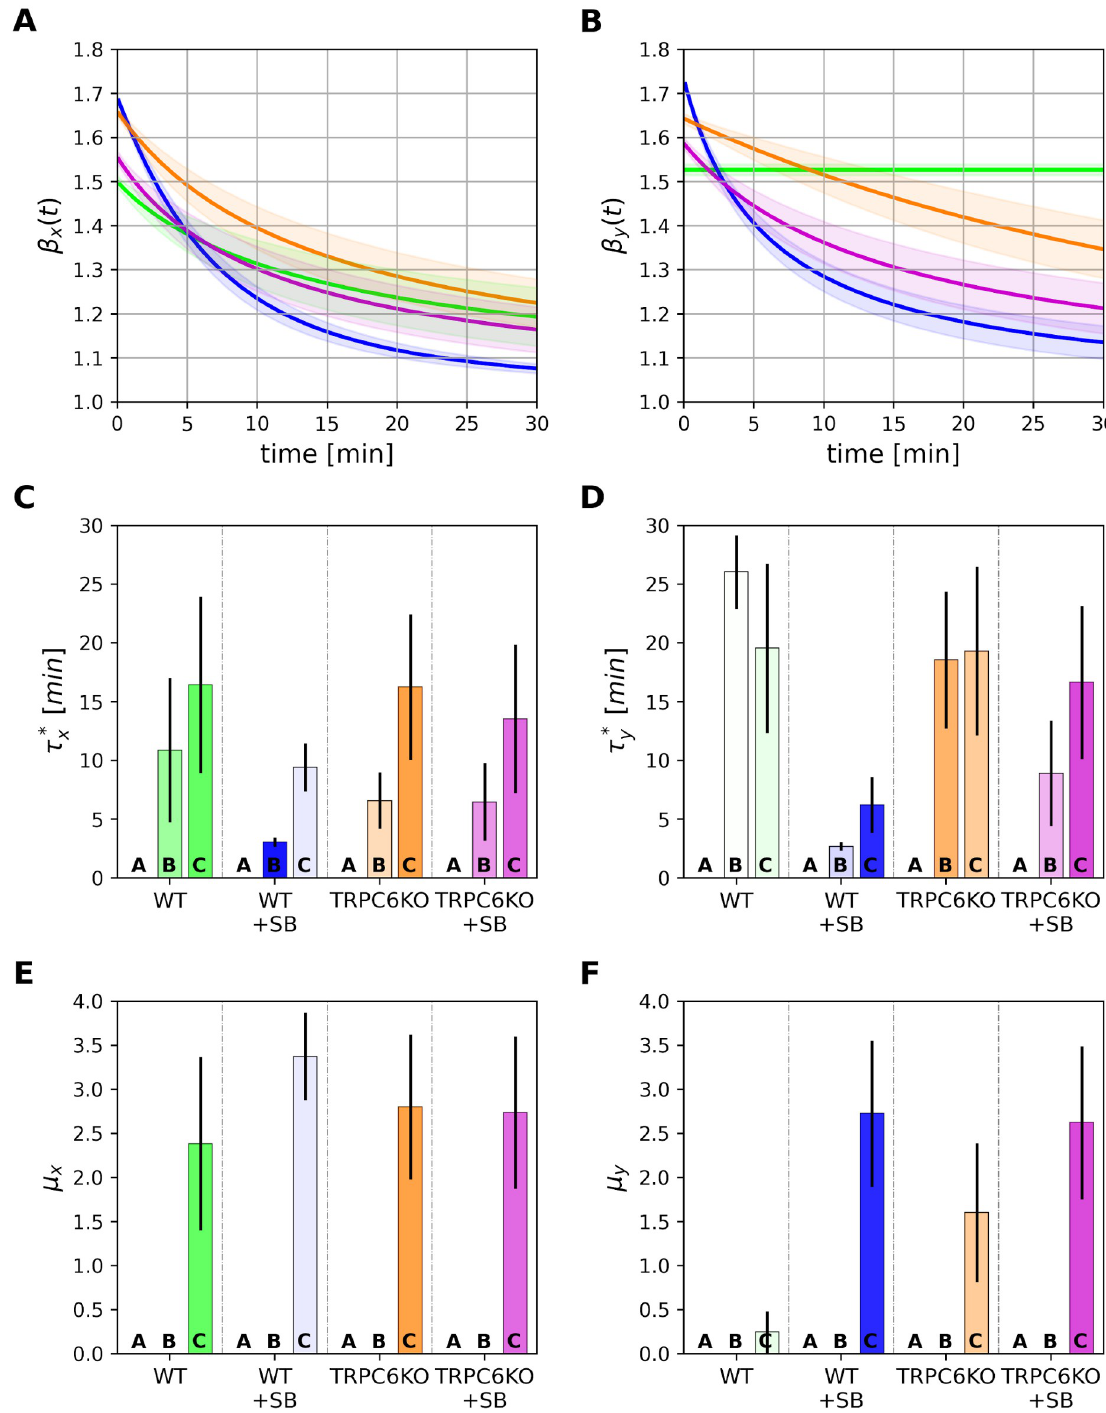
Fig 5. Tempering behavior of murine neutrophils. (A) and (B) show the temporal behavior of the logarithmic derivative β ( t ) of the mean squared displacement perpendicular (A) and parallel (B) to the direction of chemotaxis. The time-scale τ � of tempering is compared in (C) and (D) for the four different cell groups ( τ � = 1 for model A, pure fBm). (E) and (F) show the exponent μ of power-law tempering of model C. The color intensities of the parameter bars are proportional to the corresponding model probabilities given in Fig 4.